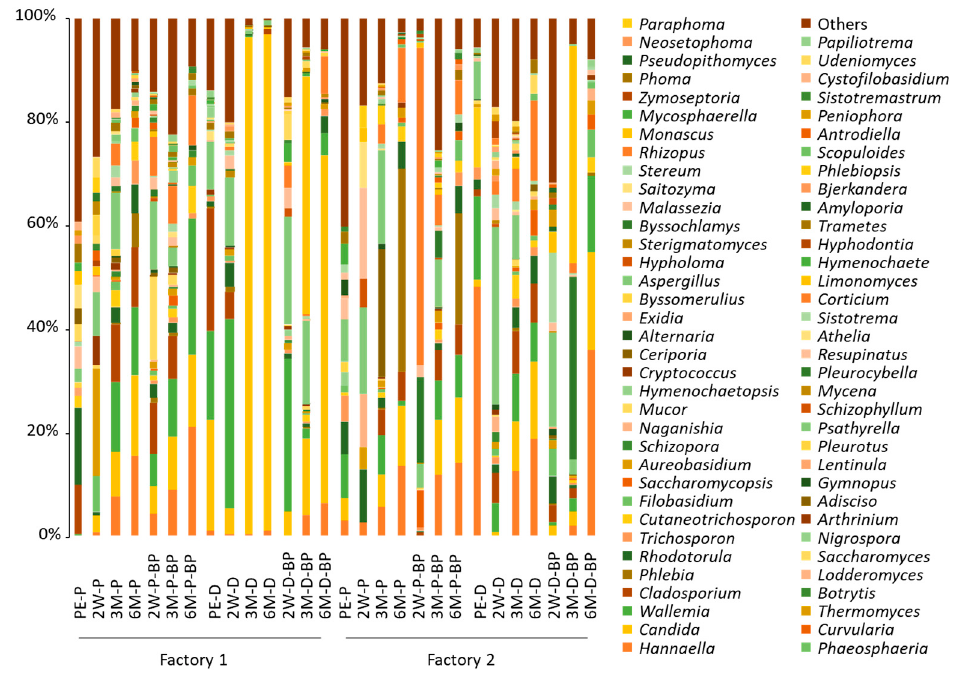
Figure 3. Genus-level fungal microbiota in soybean curd residue silage prepared with prompt and delayed sealing and with and without beet pulp addition. PE, 2W, 3M, and 6M indicate pre-ensiled material and silage stored for 2 weeks, 3 months, and 6 months, respectively. P, D, and BP after the hyphenation denote prompt sealing, delayed sealing, and beet pulp addition, respectively.